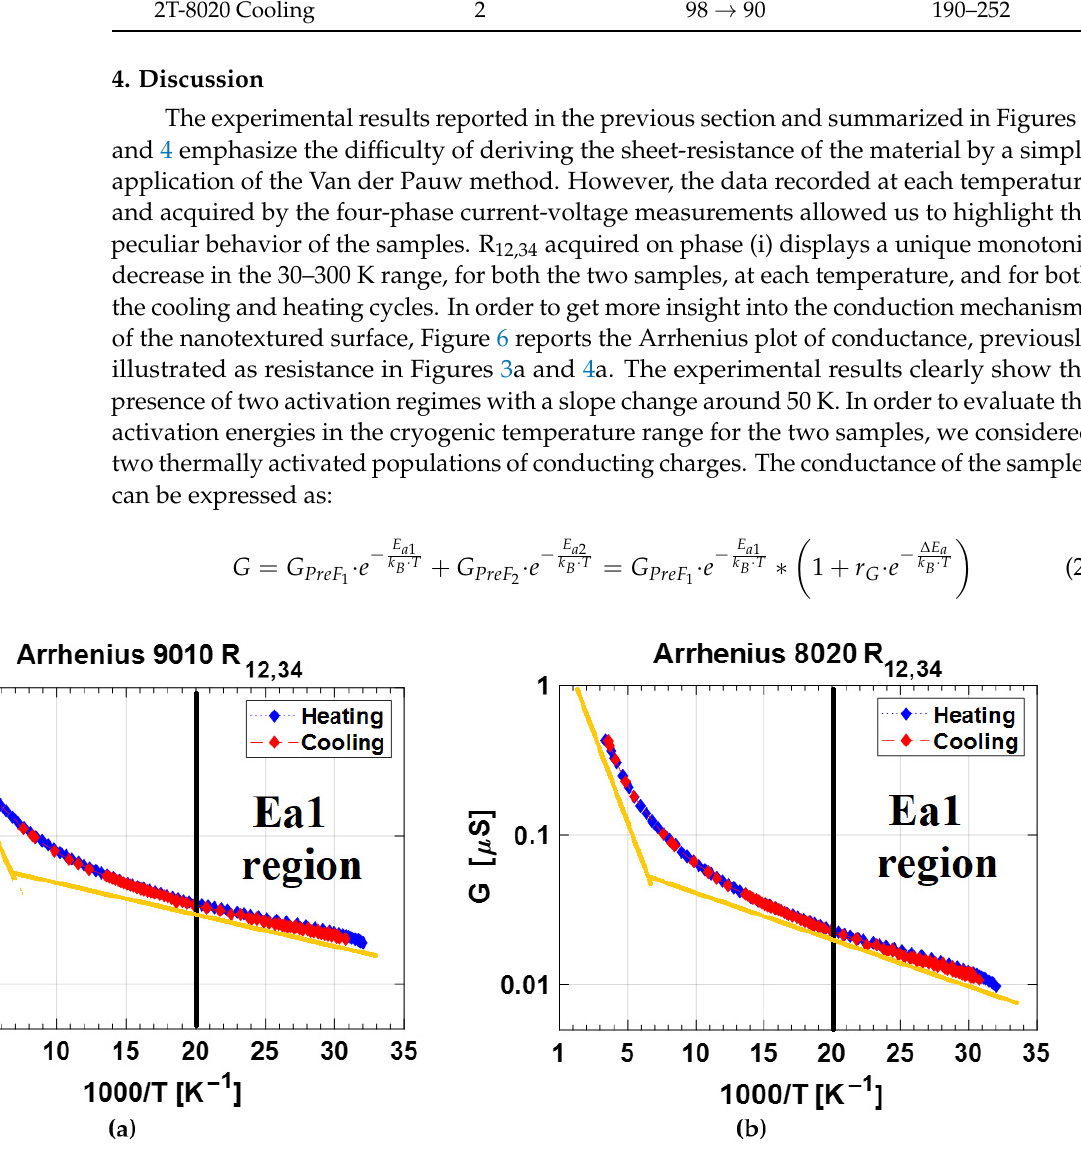
Figure 6. Arrhenius plot of conductance of ( a ) R 12,34 of sample 2T-9010, and ( b ) R 12,34 of sample 2T-8020.